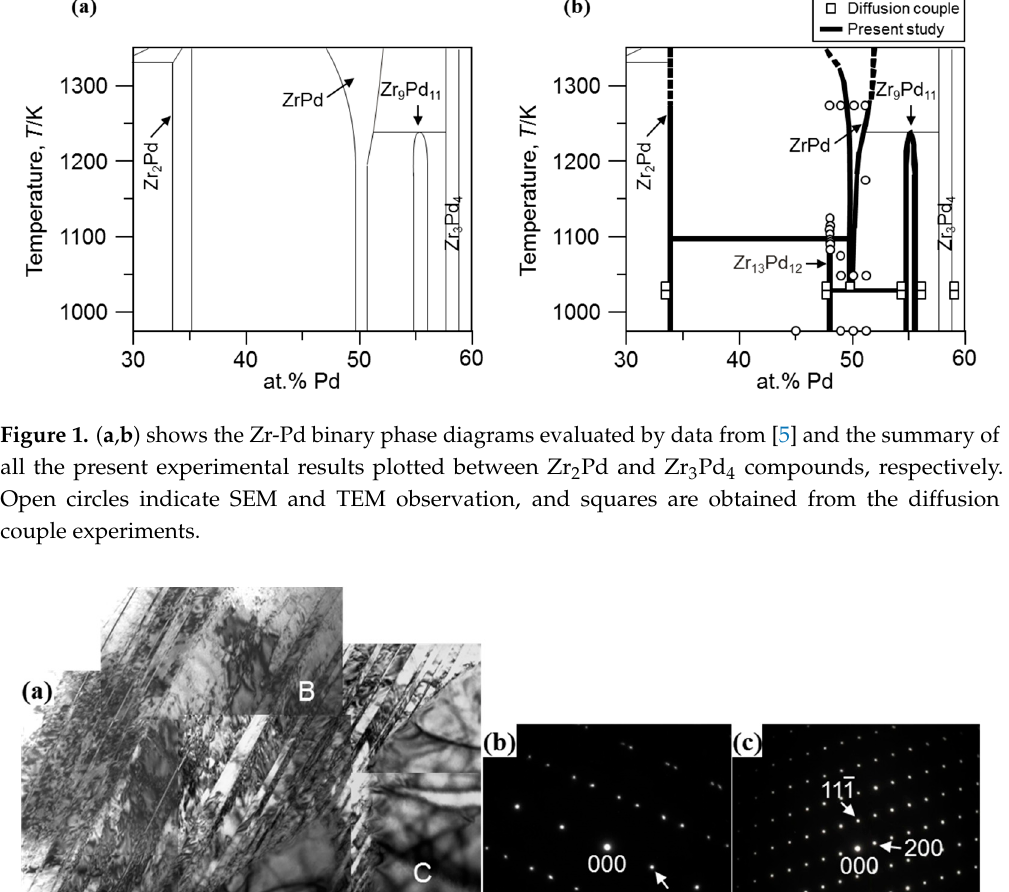
Figure 1. ( a , b ) shows the Zr–Pd binary phase diagrams evaluated by data from [5] and the summary of all the present experimental results plotted between Zr 2 Pd and Zr 3 Pd 4 compounds, respectively. Open circles indicate SEM and TEM observation, and squares are obtained from the diffusion couple experiments.